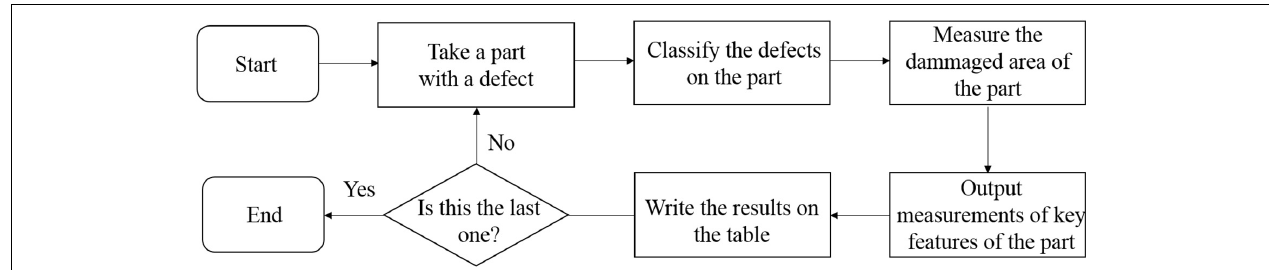
FIGURE 10 | 3D printed metal crowns quality control flowchart.